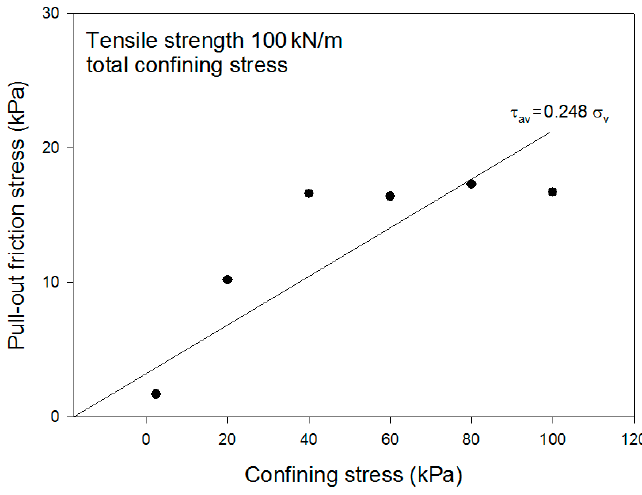
Figure 10. Relationship curve between confining stress and pullout frictional stress by total confining stress (T g = 100 kN/m).